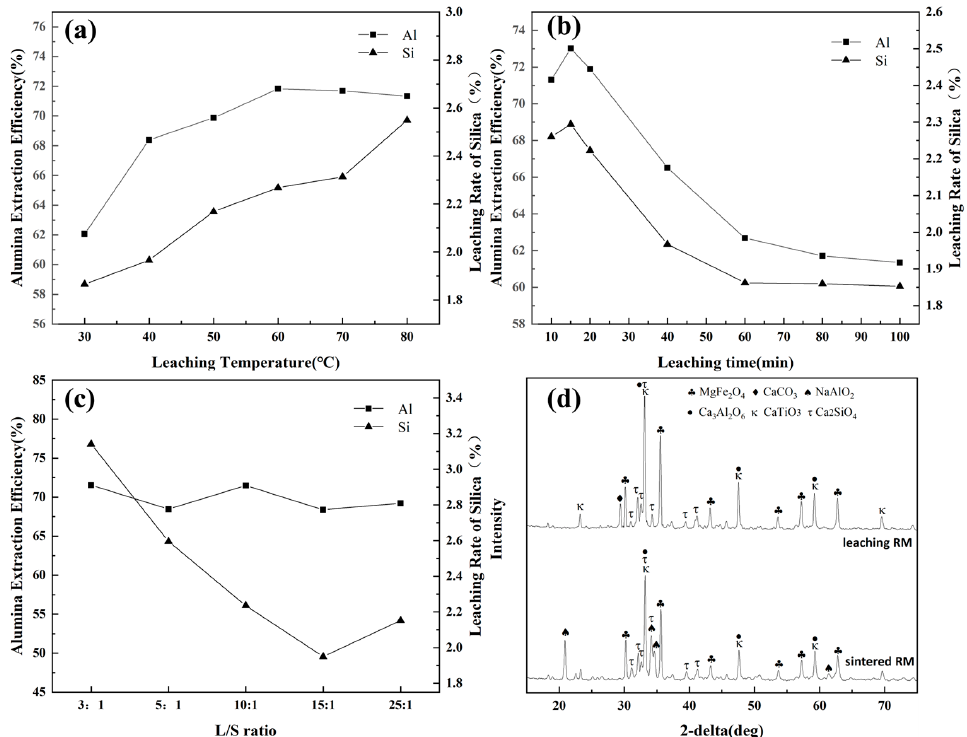
Figure 12. The dissolution rates of Al and Si in di ff erent leaching conditions: leaching temperature ( a ), leaching time ( b ), and the leaching liquid/solid (L/S) ratio ( c ); and the XRD pa tt erns of the sintered red mud and leaching red mud ( d ).